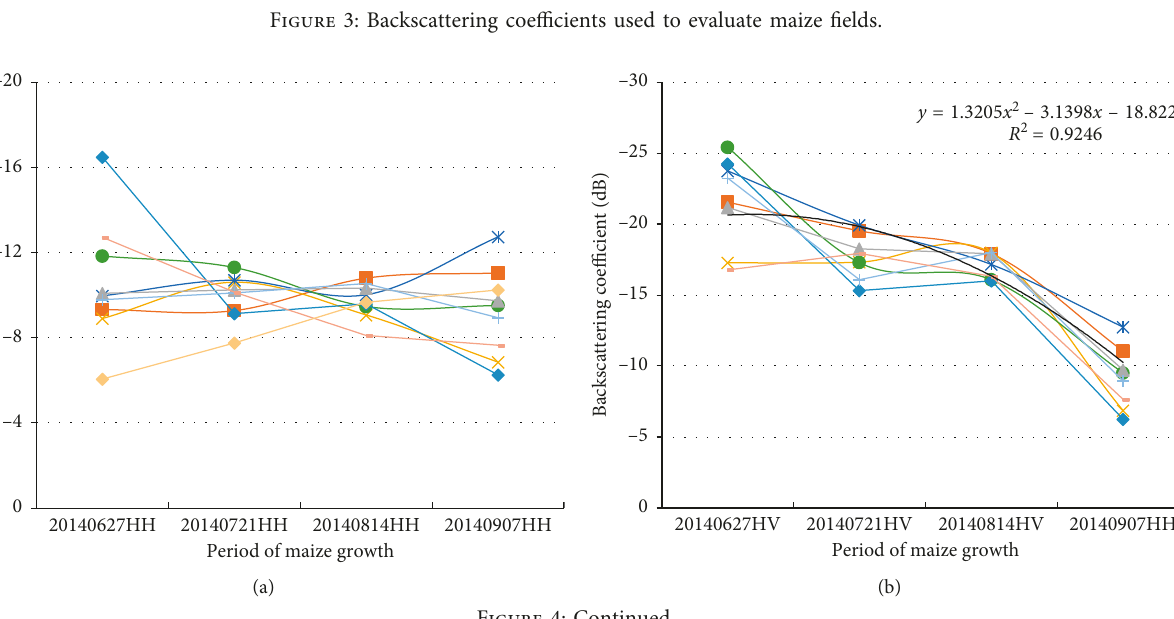
Figure 3: Backscattering coefficients used to evaluate maize fields.